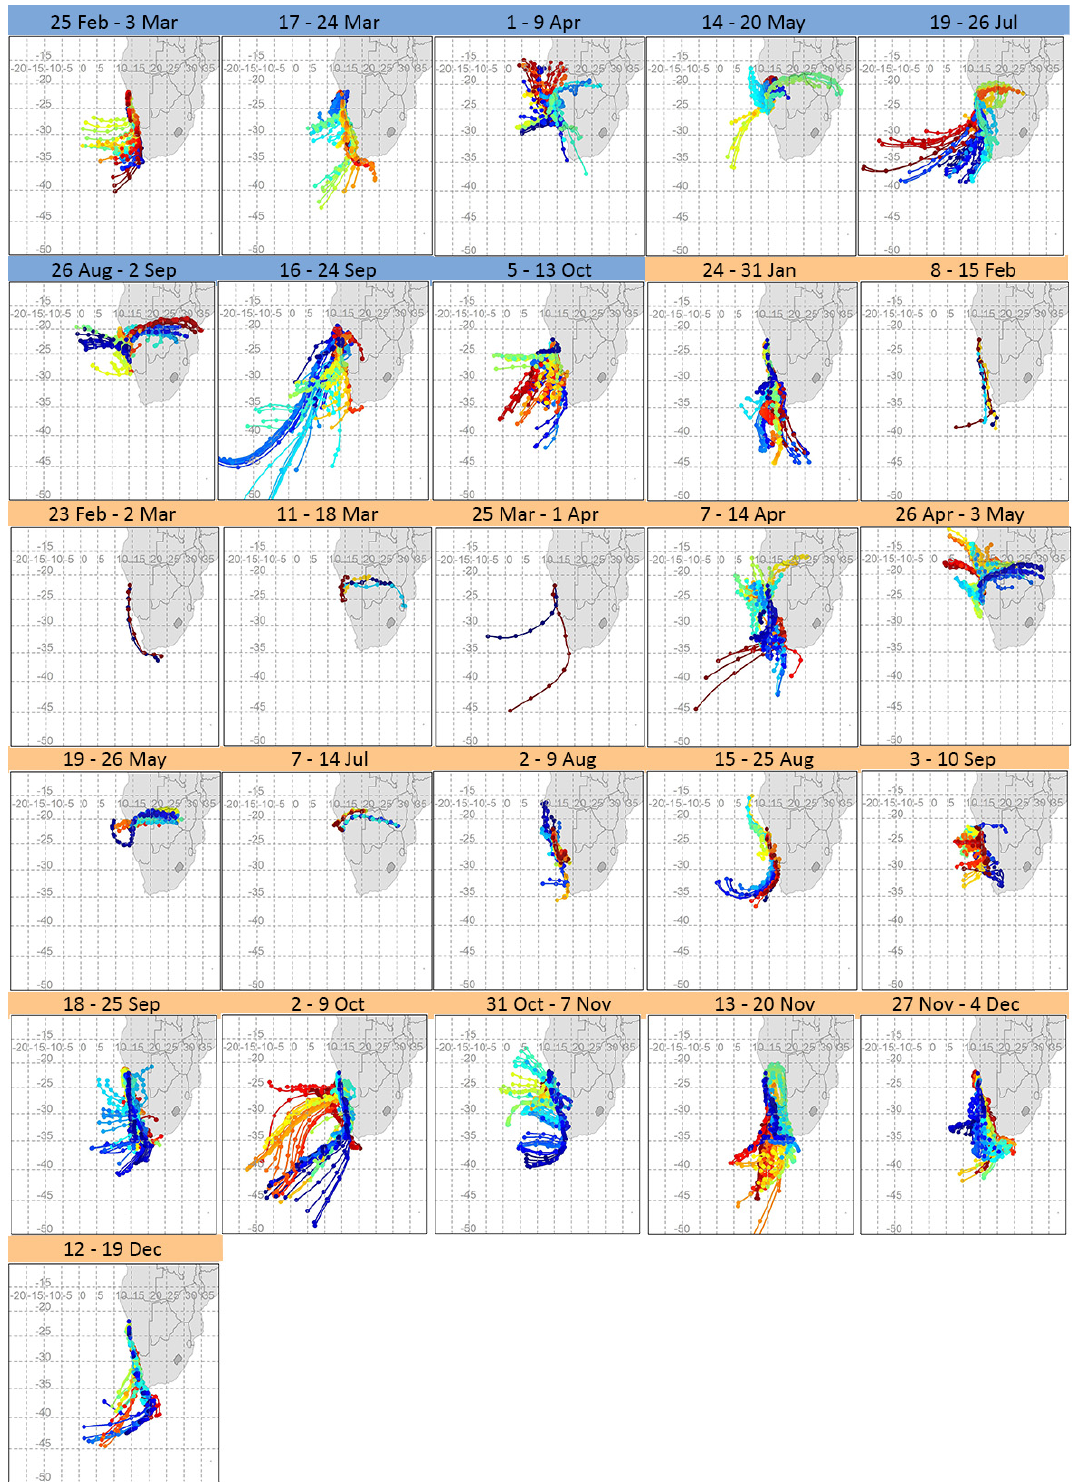
Figure 2. Composite maps of 72h back trajectories for every filter sampling period in 2016 (dates in blue) and 2017 (dates in orange). From these composite maps, a clear distinction can be made between marine air masses and those of continental origin and the potential for variability from these regions in terms of distance travelled and trajectory pathway. The colours are only used to differentiate one set of trajectories from